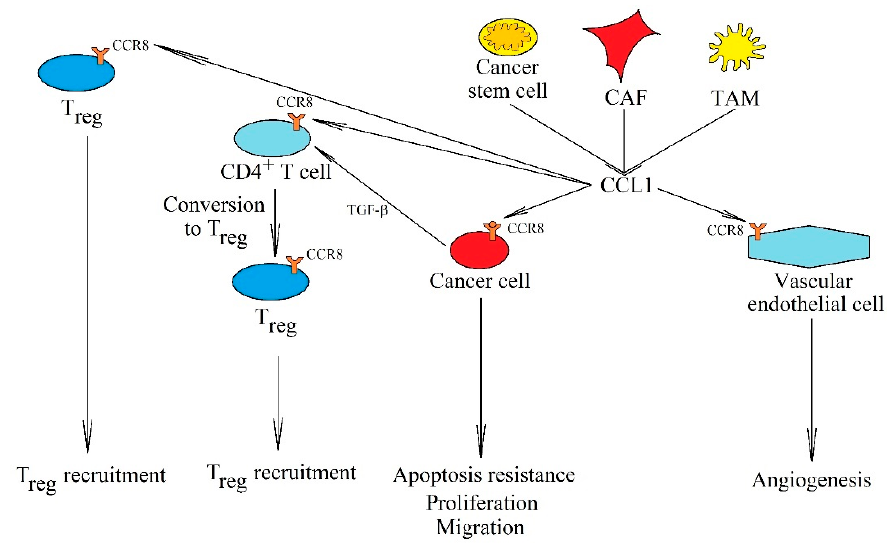
Figure 5. The significance of the CCL1 → CCR8 axis in cancer processes. CCL1 is secreted into the cancer microenvironment by cancer stem cells, CAF and TAM. This chemokine has many primary tumor functions. By activating the CCR8 receptor on cancer cells, it causes their proliferation, apoptosis resistance, and migration. It also causes angiogenesis by activating its CCR8 receptor on endothelial cells. Another important function is the recruitment of T reg into the tumor niche and causing the conversion of CD4 + T cells into T reg .